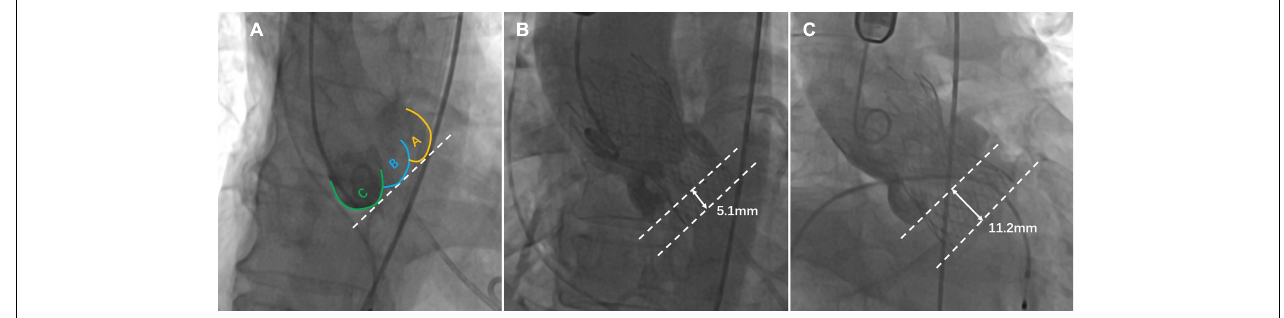
FIGURE 2 | The implantation depth of the Venus-A prosthesis was measured postoperatively from fluoroscopic images (the dashed lines represent the annular plane and the Venus-A valve base plane, respectively). (A) Distribution of three calcified regions on fluoroscopic images; (B) standard implantation depth; and (C) implantation position that is too deep.